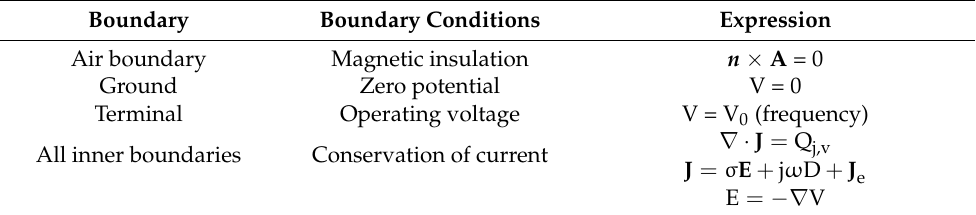
Table 2. Boundary condition